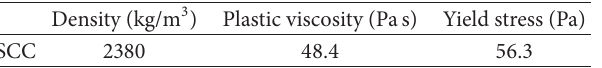
Table 1: Density and rheological properties of SCC for simulation